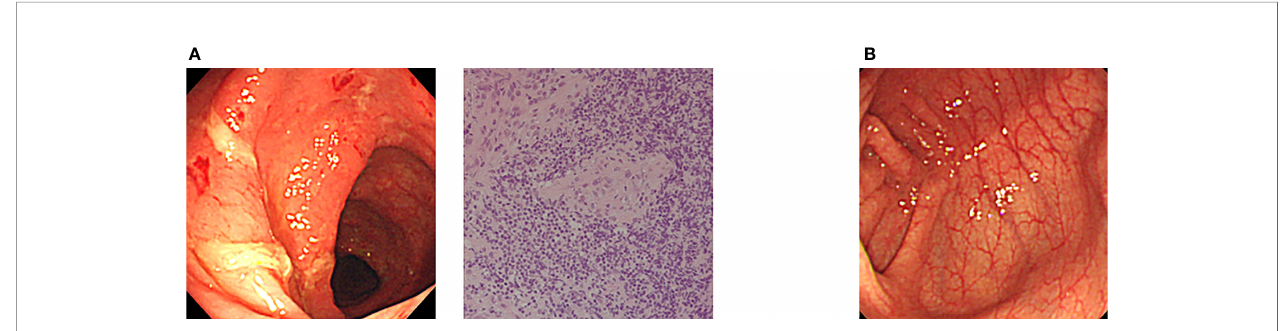
FIGURE 2 | Amelioration of endoscopic fi ndings after allogeneic CBT in a Japanese patient with XIAP de fi ciency. (A) Endoscopic evaluation at onset showed edema, hemorrhage and ulcer formation. Pathological evaluation of biopsy specimen at onset showed nonspeci fi c active in fl ammation. (B) Completely ameliorated endoscopic fi nding after allogeneic CBT in the same patient (17,